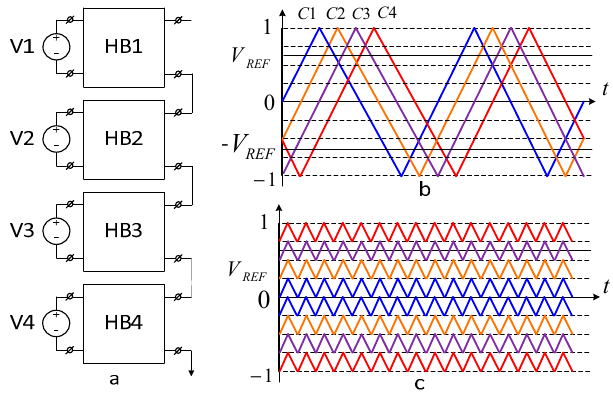
Figure 1. Single-phase cascade H-bridge (CHB) inverter: ( a ) topology example for four H-bridges; ( b ) phase-shifted (PS) pulse width modulation (PWM) carriers; ( c ) level-shifted (LS) PWM carrier arrangement.